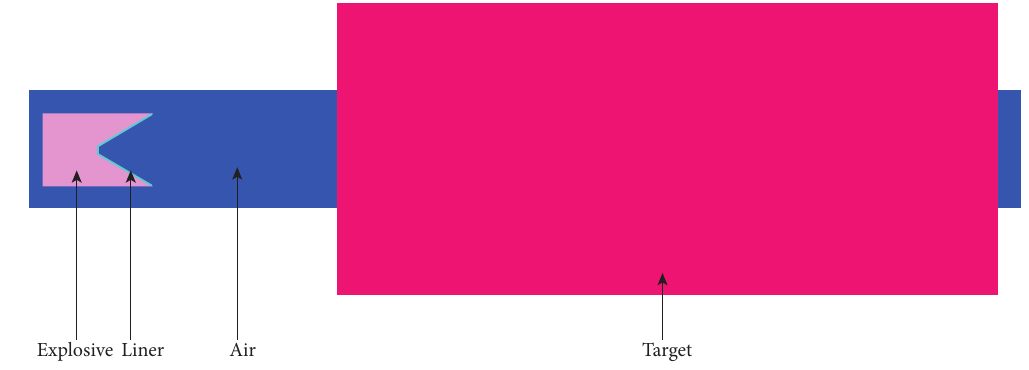
Figure 2: Finite element model of micro-shaped charge penetrating gelatin target. Table 1: Main material parameters for